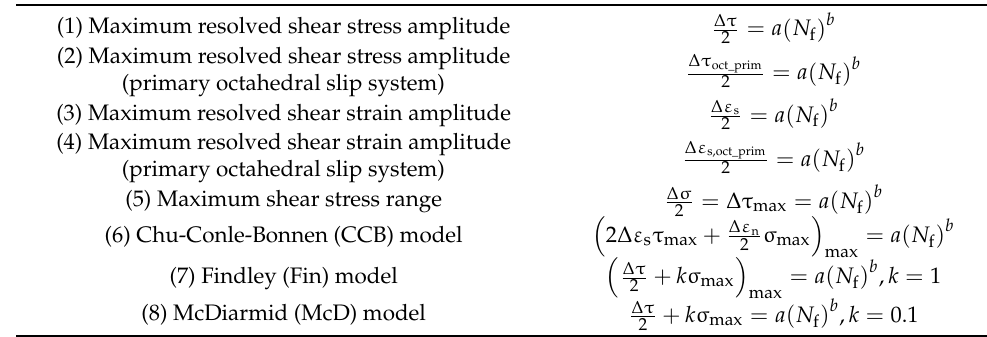
Table 3. Nickel-based single crystal fatigue life prediction model